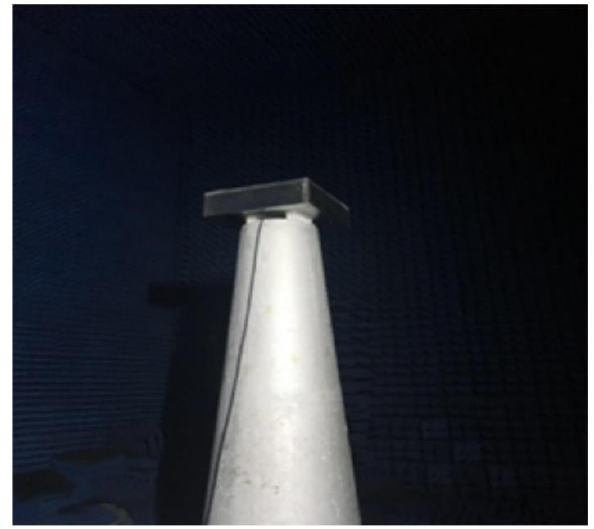
Figure 18. The experimental condition in the microwave dark chamber. Table 3. The results obtained by the simulation and experiments with different conditions.